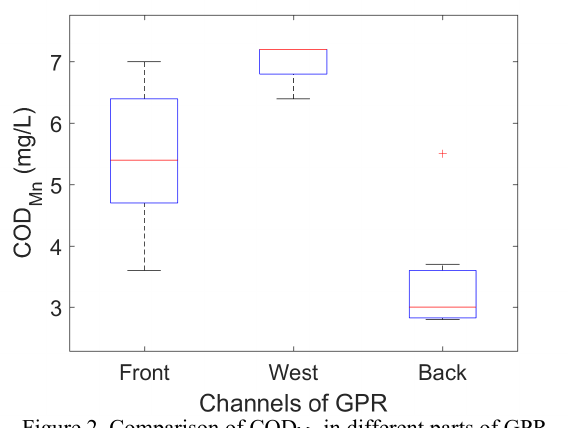
Figure 2. Comparison of COD Mn in different parts of GPR